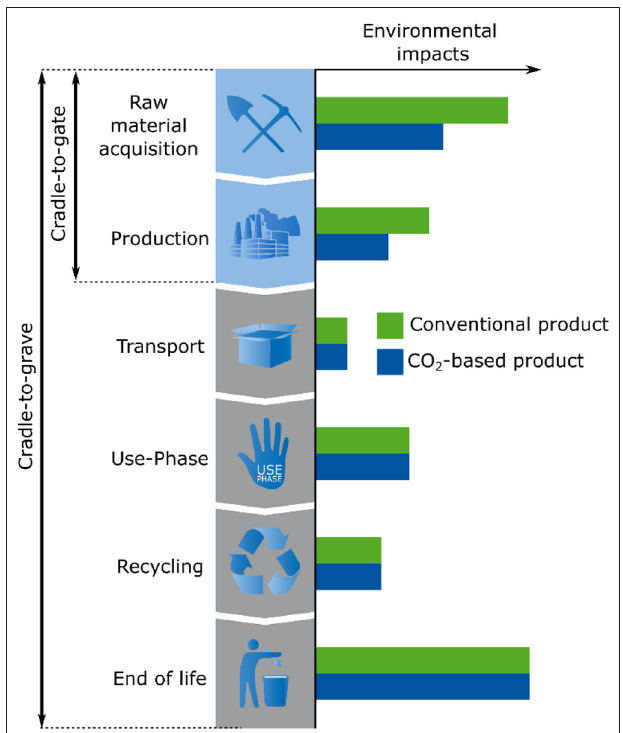
FIGURE 3 | Illustration of a comparison of environmental impacts for products with identical chemical structure and composition over the entire life cycle. Impacts shown as bars on the x-axis only differ during the phases raw material acquisition and production and thus, comparative studies only have to consider these